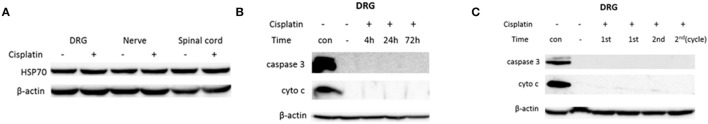
Cisplatin does not induce markers of apoptosis in neuronal tissue. Mice were treated with PFT-μ (8 mg/kg) or vehicle 1 h prior to an i.p. injection of cisplatin (2.3 mg/kg) or vehicle. Dorsal root ganglion (DRG), sciatic nerve, and lumbar spinal cord were collected at various time points. Whole-cell lysates or cytosolic fractions were analyzed by Western blotting. (A) Western blot analysis of heat-shock protein 70 (HSP70) on whole cell lysate from tissues collected 4 h after single cisplatin treatment. (B–C) Western blot analysis of apoptotic markers: cytosolic cytochrome c and cleaved caspase 3: of DRG tissues collected 4, 24, and 72 h after a single dose of cisplatin (2.3 mg/kg) (B), and DRG collected on a last day of 1st and 2nd cycle of 5 daily cisplatin injections per cycle (the final cumulative dose of cisplatin was 11.5 and 23 mg/kg, respectively) (C). “Con” designates positive controls: whole cell lysate of H2O2-treated N2A cells for cleaved caspase 3, and lysate of a mitochondrial fraction for cytochrome c. Data of one representative experiments out of three with 3 mice per group for each measure are presented. β-actin was used as a loading control.